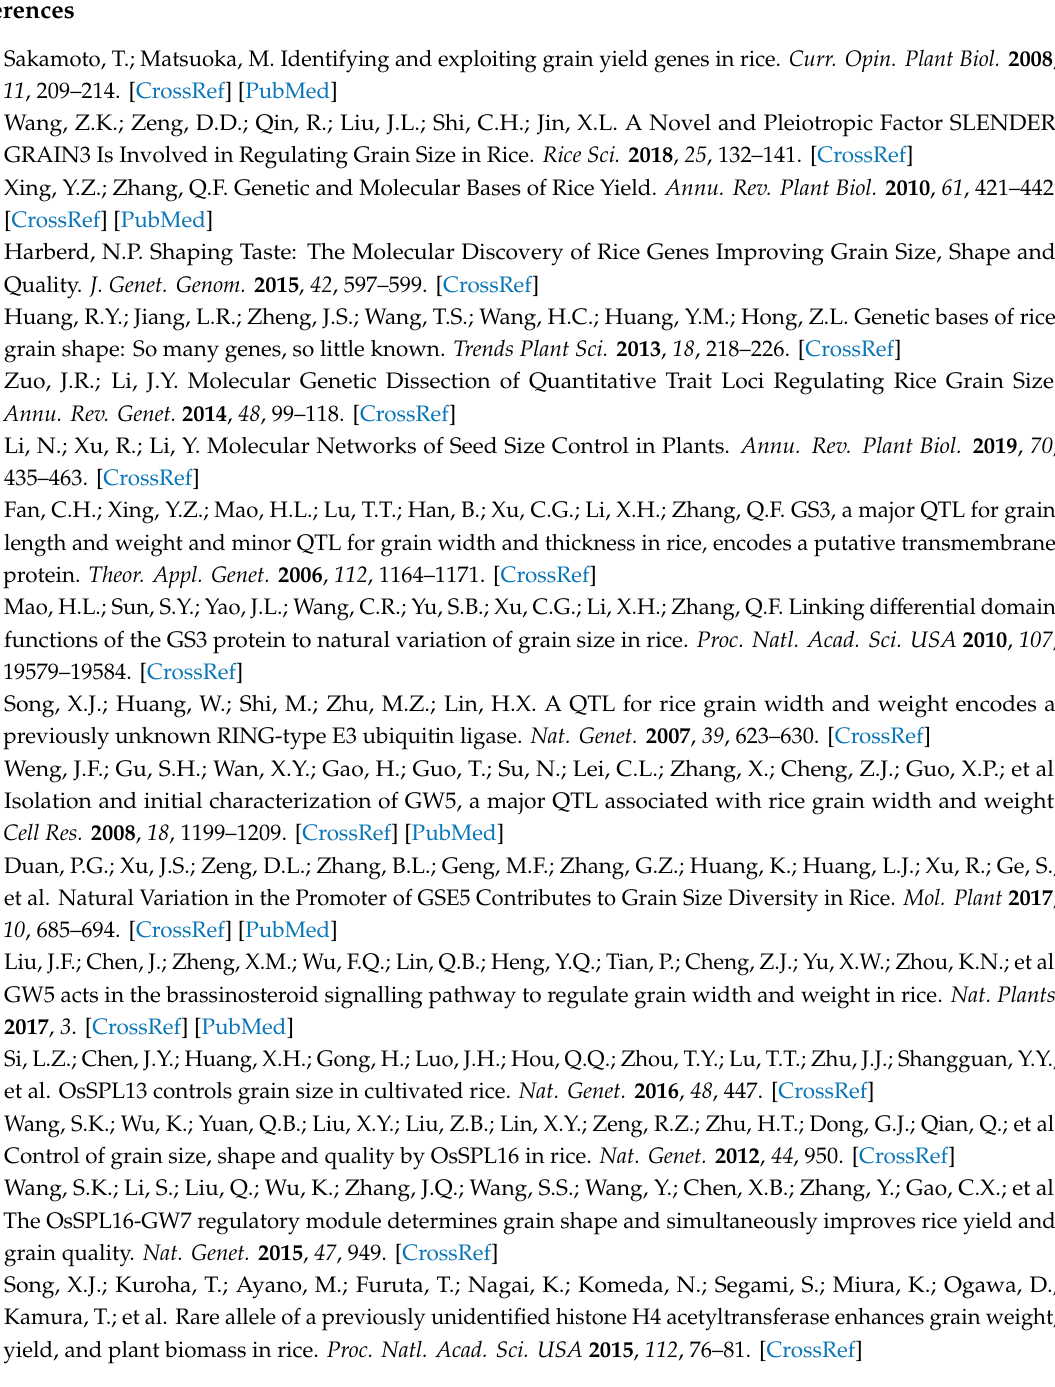
Figure S1. Graphical genotype of RHL2401 line on 12 rice chromosomes; Table S1. The primer used in this study; Table S2. Mutant site of erect panicle and small round